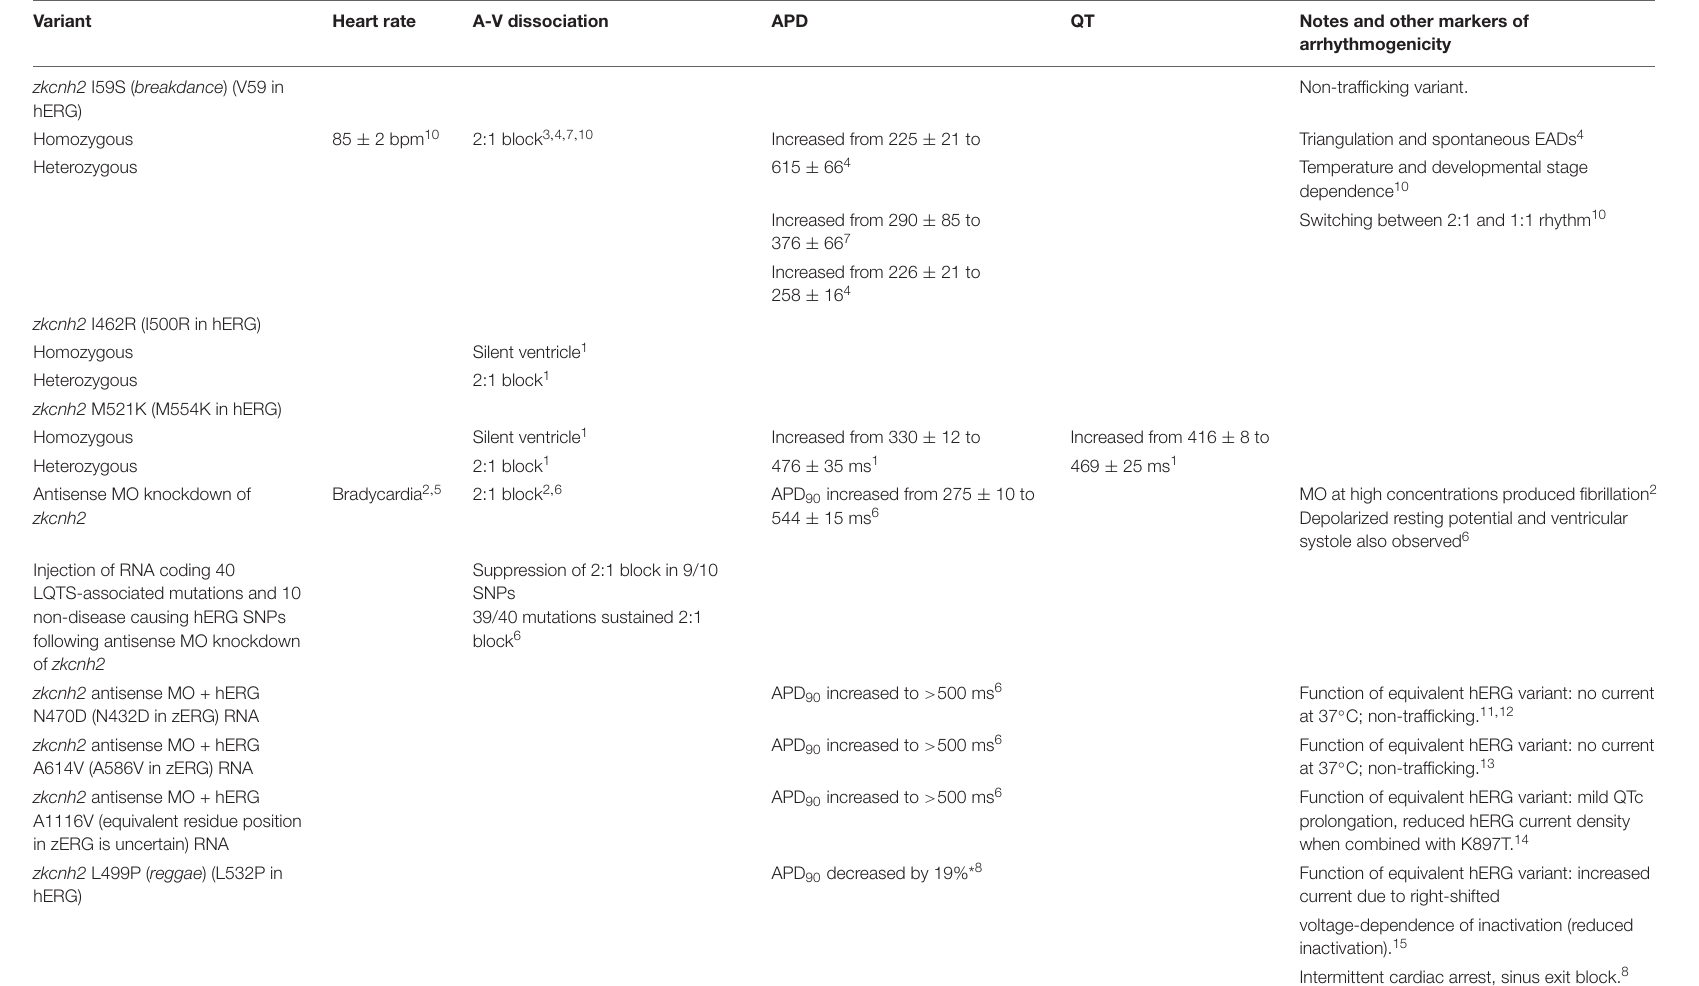
TABLE 2 | Effects of inherited mutations or targeted disruption of the zERG gene on cardiac electrical activity.